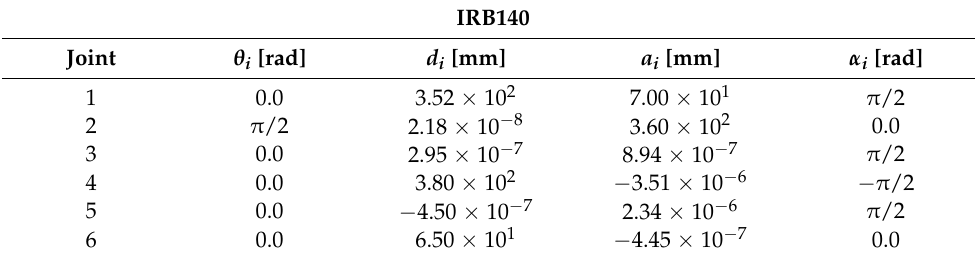
Table 2. D-H parameters for the IRB140.